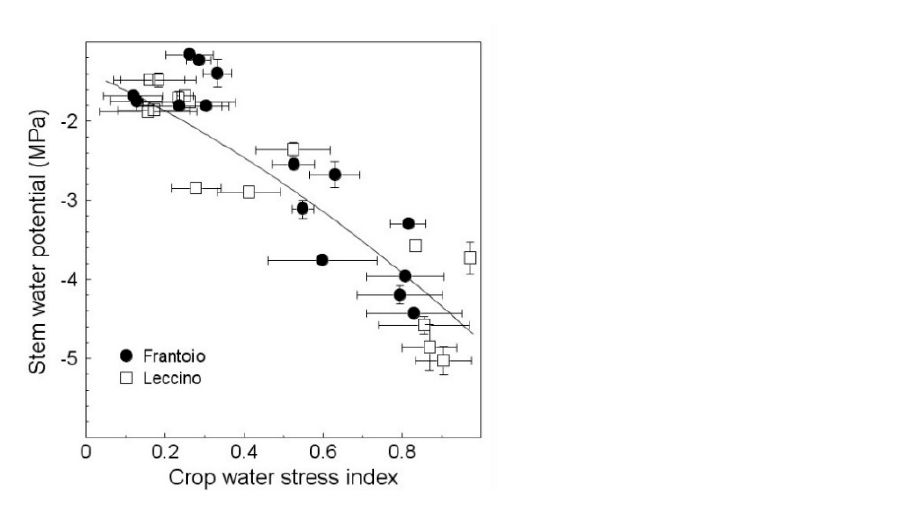
Figure 3. The relationship between crop water stress index (CWSI), calculated by UAV infra-red thermal imagery, and stem water potential (SWP) measured in the same days on olive trees (cvs. Frantoio and Leccino) subjected to full irrigation, deficit irrigation, or rainfed conditions in 2020. Measurements were taken at DOY 175, 210, 225, 232, and 253. Each symbol represents the mean of three trees. Vertical and horizontal bars are standard error for SWP and CWSI, respectively. Regres-